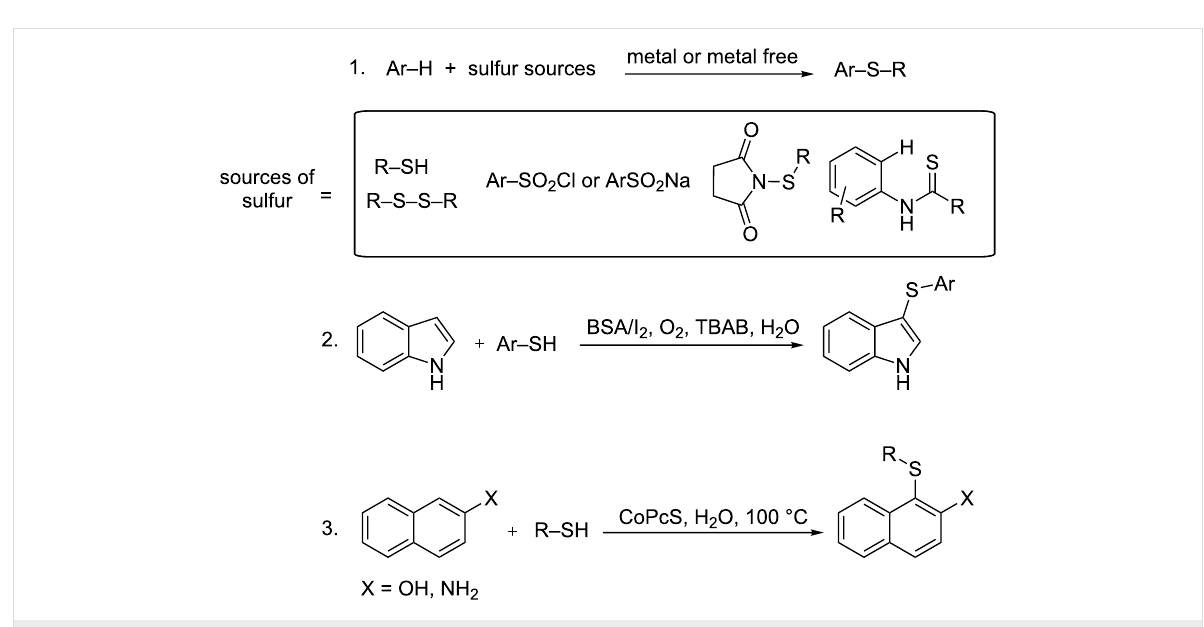
Scheme 1: Synthetic routes to organosulfur